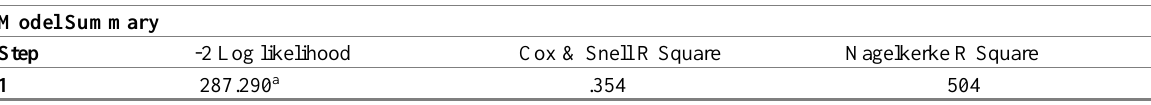
Table 4: Model Summary